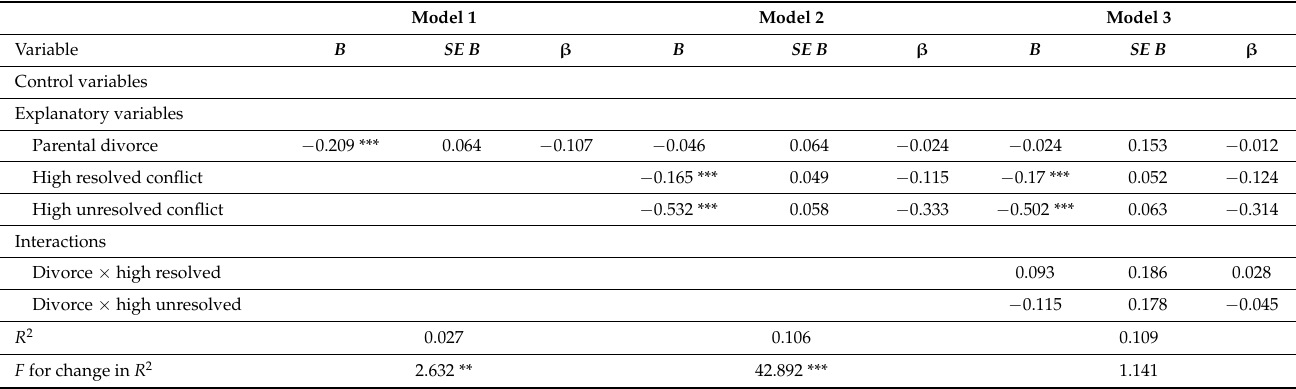
Table 3. Summary of the hierarchical multiple regressions for the variables predicting trust in mother-child